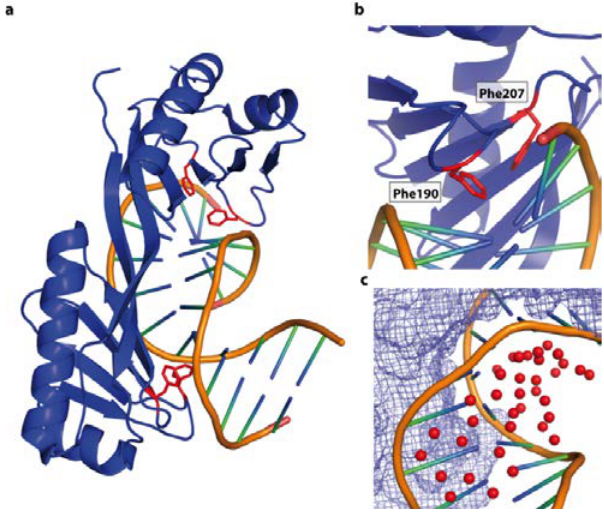
Figure 11. DNA shape recognition of the TATA box by the TBP binding (PDB code 1YTB). ( a ) Overall view of the complex. TBP is interacts with the minor groove, resulting in a compressed major groove. The contacts are dominated by van der Waals’ interactions occurring between nonpolar and polar atoms. The DNA is heavily unwound (105°) and displays two sharp kinks (highlighted in red); ( b ) Penetration of the double helix by Phe 190 and Phe 207 at the kink site; ( c ) The water molecules (red spheres) stabilize the major groove of the DNA. The protein surface is shown as blue